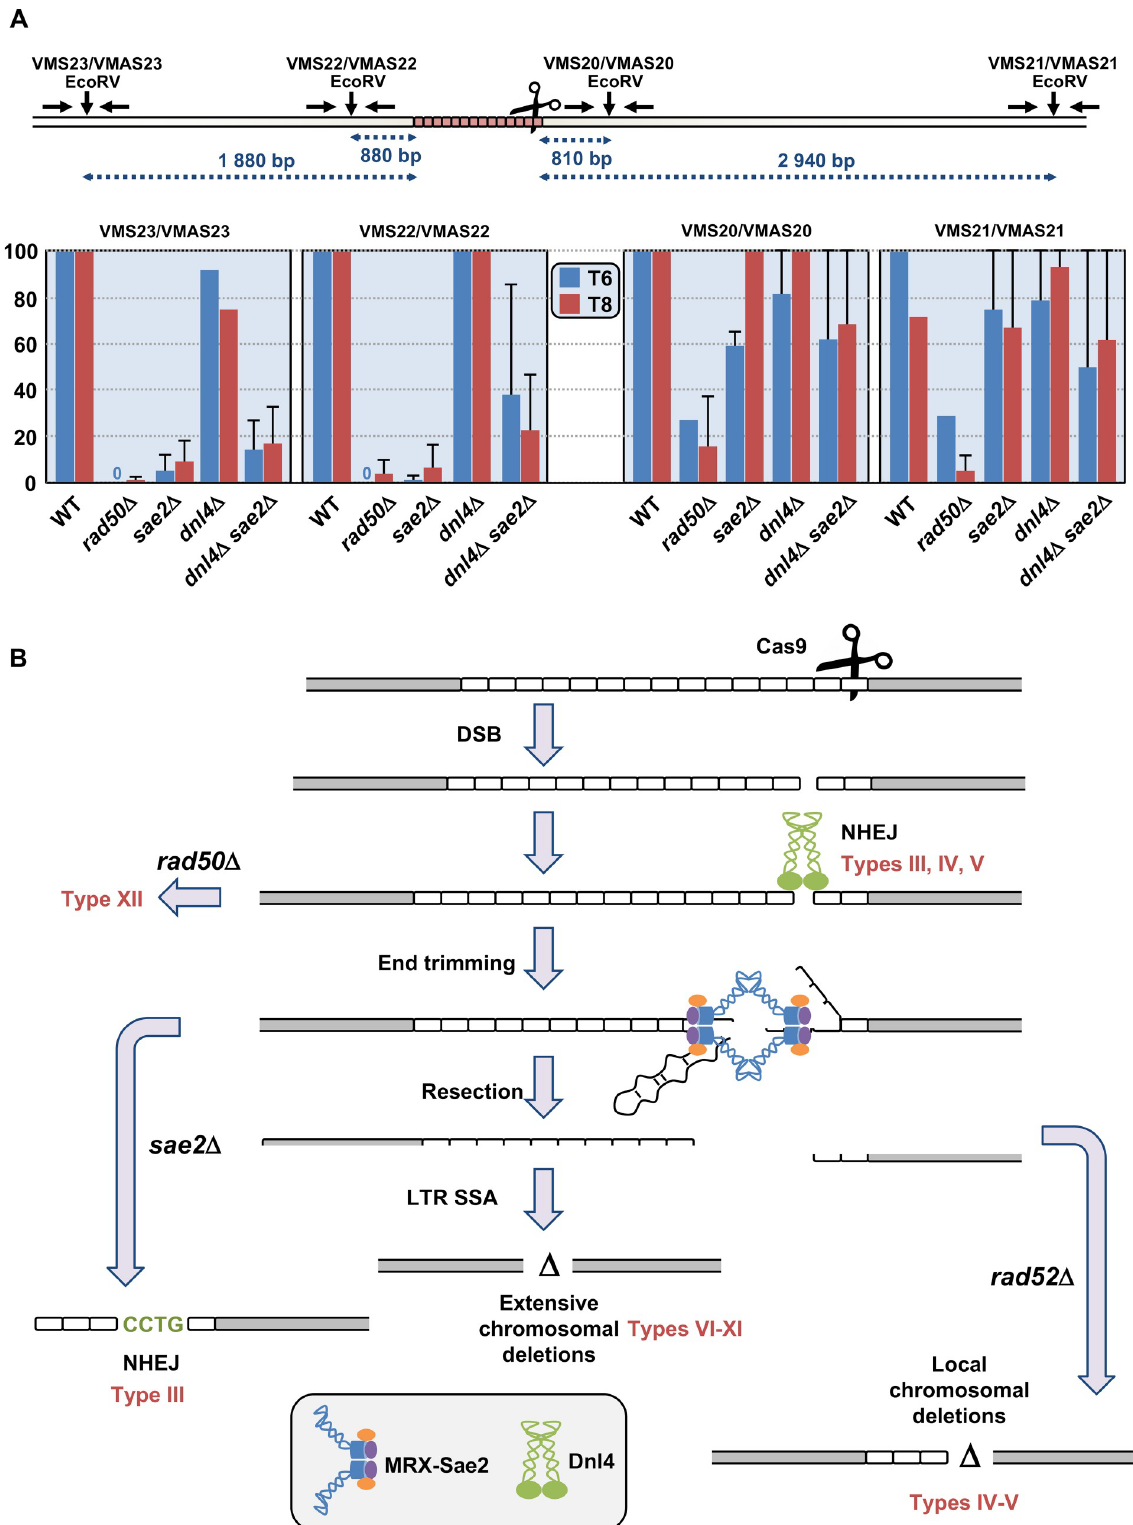
Fig 7. Quantification of double-strand break resection. A : Couples of primers used to amplify each EcoRV site are indicated above and can be found in S3 Table. EcoRV sites are shown by vertical arrows. Resection graphs are plotted for each primer pair. Average relative values